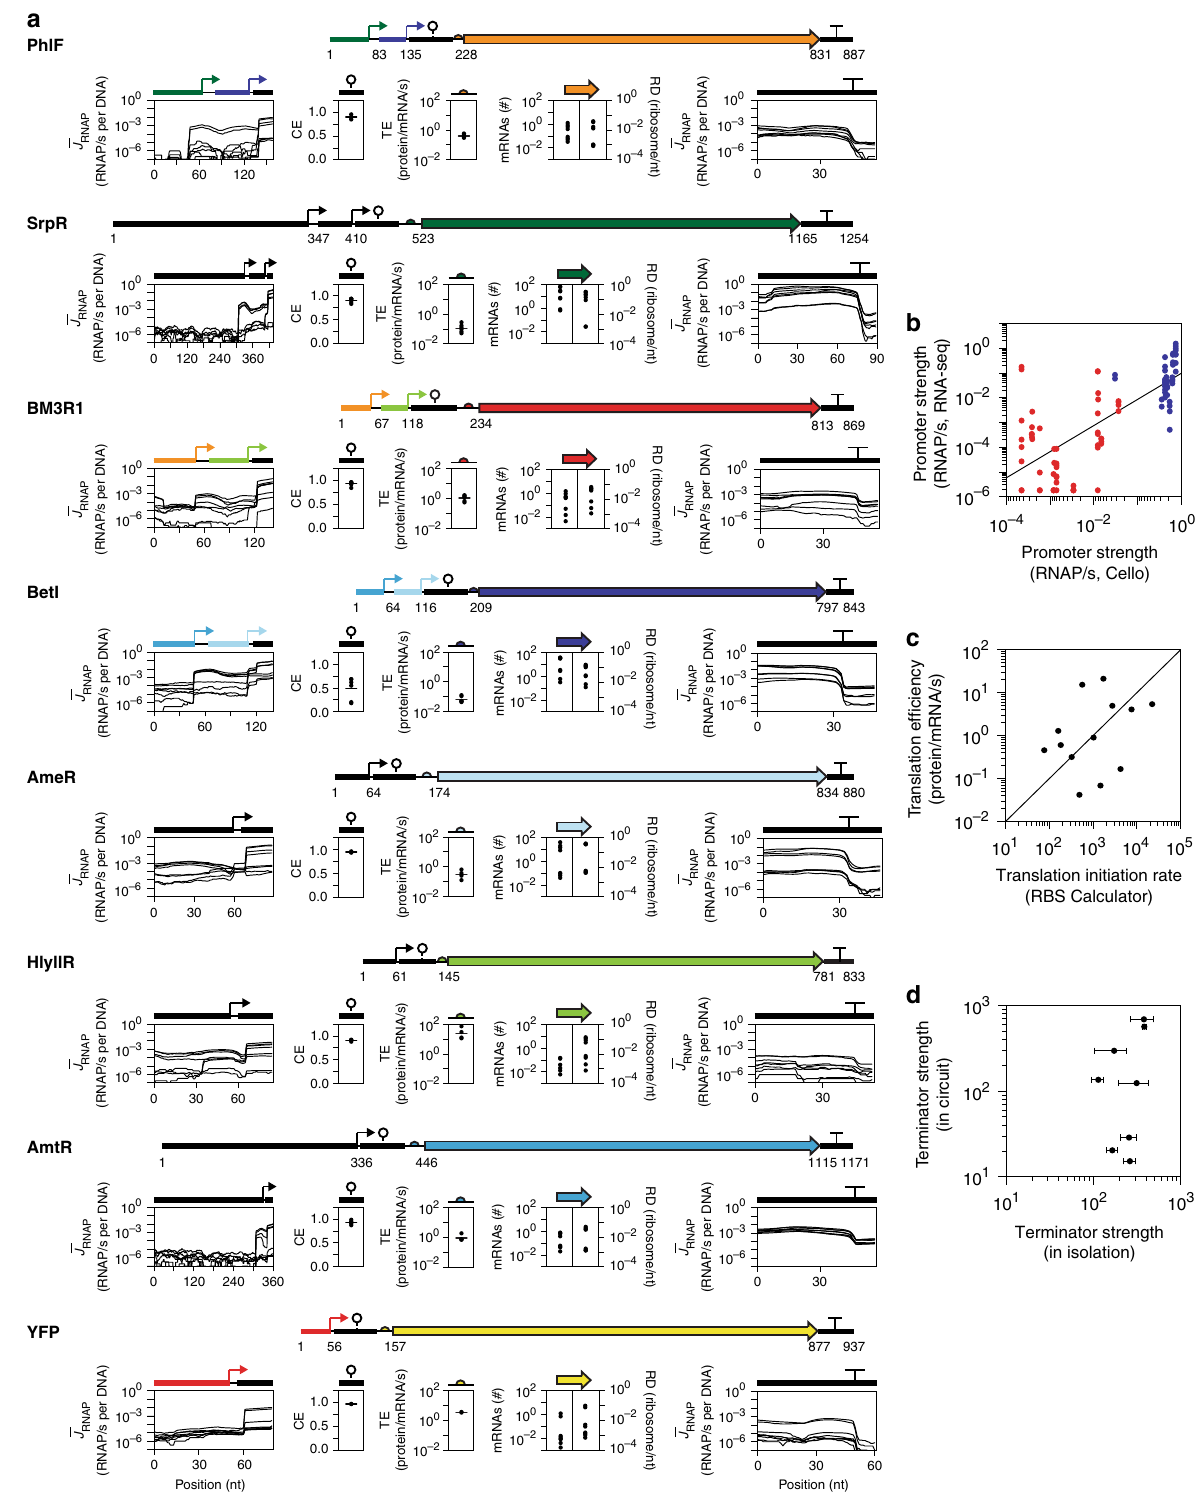
Fig. 3 Complete characterization of genetic circuit parts. a The data are organized by the eight transcription units in the circuit. For promoters and terminators, the transcript pro fi les for all circuit states are shown, with the TSS and TTS marked with an arrow or T, respectively. The ribozyme CE and RBS TE values are shown for the states where the repressor is transcribed (average marked by the horizontal line). The estimated transcript and protein (RD) levels for the genes are shown for the eight induction states. b The promoter activities for the promoters as measured by RNA-seq are compared to the values predicted by Cello. Data are shown for all 12 promoters within the circuit for the eight induction states. The points are shown in red if the promoter should be off and blue if it should be on. c The TE measured for the circuit genes in the most highly transcribed state are compared against their predicted translation initiation rate (TIR) (Methods). d The terminator strengths of all eight terminators as measured using RNA-seq in their most highly transcribed state are compared to their previously measured values in isolation using fl uorescence-based assays (data and error bars are from ref. 27 , n ≥ 3 independent measurements on different days). Source data are provided as a Source Data fi